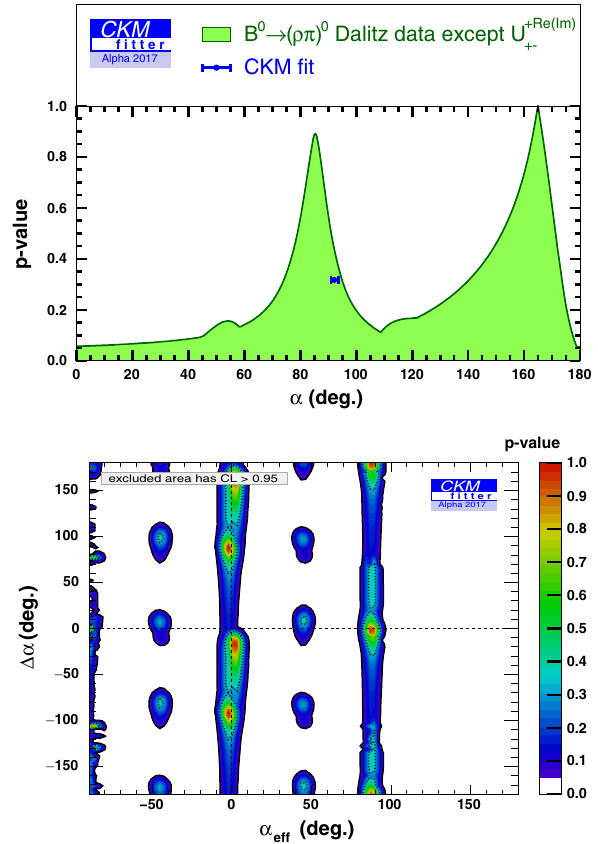
Fig. 38 Top One-dimensional scan of the angle α using the B 0 → + I m (ρπ) 0 Dalitz data except the two coefficients U + R e +− and U +− , which measure the real and imaginary parts of ( A + A − ∗ + ¯ A + ¯ A − ∗ ) . The inter- val with a dot indicates the indirect determination of α introduced in Eq. (2). Bottom Two-dimensional constraint in the ( α eff , (cid:13)α ) plane. As for other similar figures in this article, the excluded region corresponds to CLs above 2 σ . The standard solution around ( 90 ◦ , 0 ◦ ) is